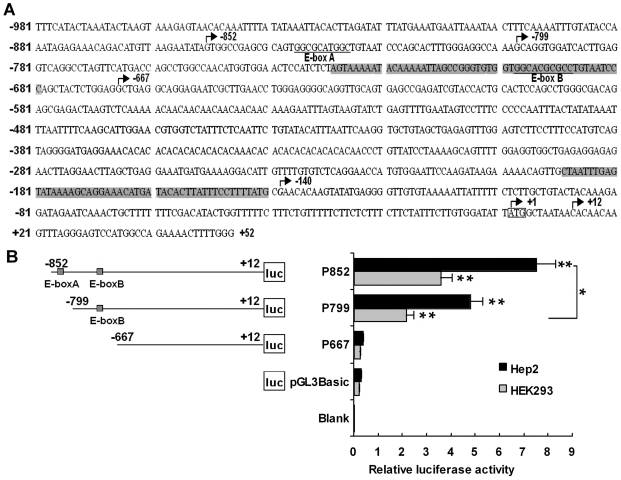
Identification and functional characterization of human MYCT1-TV promoter.
A. Nucleotide sequence of the promoter region (from −981 to +52) of human MYCT1-TV. The putative binding sites for transcriptional factors are underlined and markded as E-box A and B. The transcriptional start site is marked in bold and italic at −140 bp. The start nucleotide of the published MYCT1 mRNA sequence is marked in bold at −152 bp. The positions of putative core promoter sequences are marked with gray color. The numbering of the nucleotides starts at initiator codon ATG (+1) which are boxed. B. Analysis of human MYCT1-TV promoter activities detected by luciferase assay. Hep2 (black bars) or HEK293 (gray bars) cells are transiently transfected with 0.8 µg of the deletion constructs together with 16 ng pRL-TK. The relative activities of a series of deletion constructs are determined by luciferase assay (**, p<0.01; *, p<0.05).